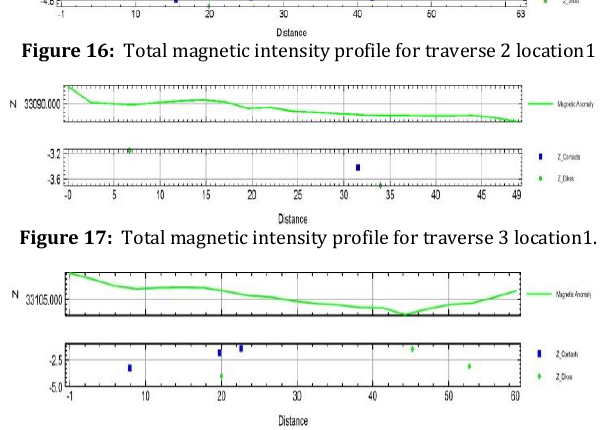
Figure 18: Total magnetic intensity profile for traverse 1 location 2